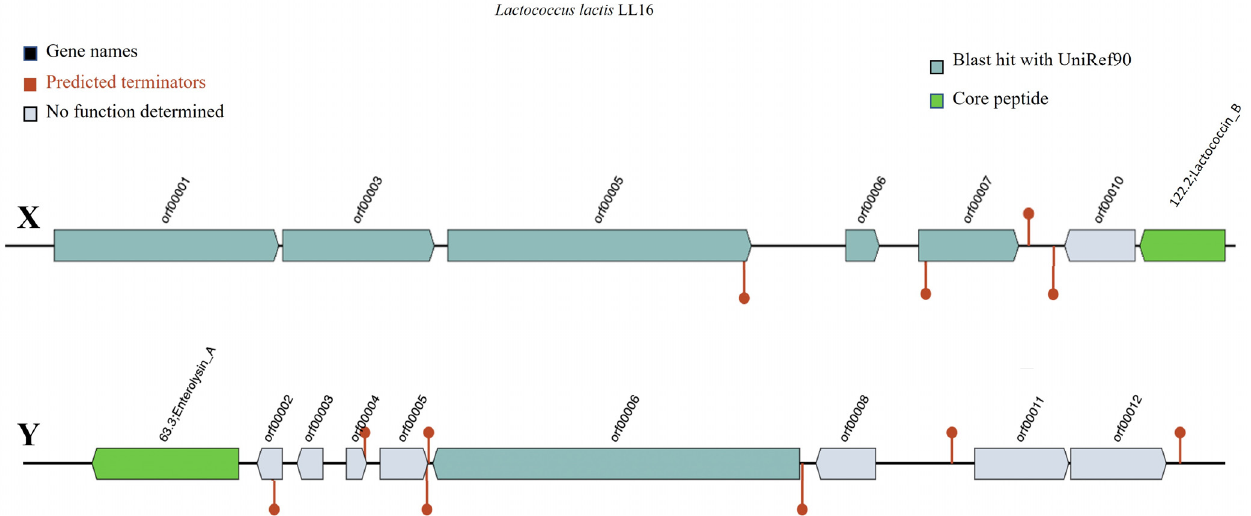
Figure 2. Representation of gene clusters coding the production of putative bacteriocins Lactococcin B (X) and Enterolysin A (Y) in the genome of L. lactis LL16 using the online webserver BAGEL v.4.0. Predicted terminators are shown as the maroon line circle ends.